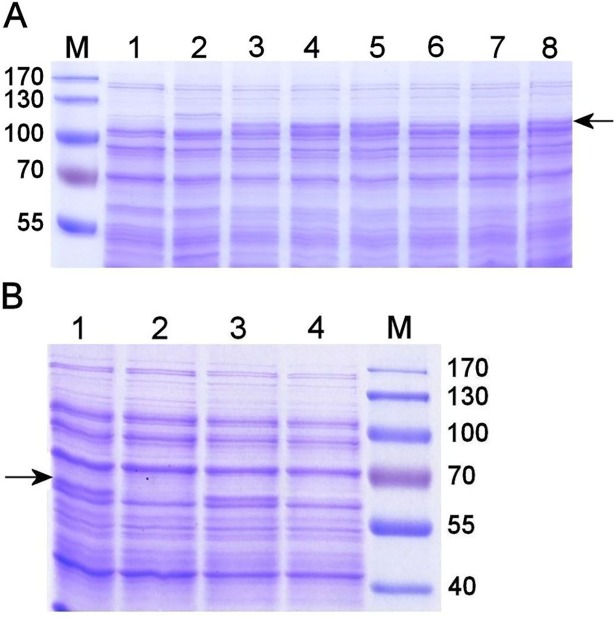
SDS-PAGE analysis of recombinant sialidases in E. coli lysates.(A) Filtered soluble fraction of cell lysates containing full-length sialidase from G. vaginalis isolates 47.3 (lane 3), 58.4 (lane 4), 60.1 (lane 5), 79.2 (lane 6), 86.1 (lane 7), and 114.2 (lane 8). As controls, filtered soluble fractions of E. coli cell lysate before induction (lane 1) and of non-transformed cells (lane 2) were loaded on the gel. (B) The catalytic domain of sialidase from G. vaginalis isolates 86.1 and 114.2 was expressed in E. coli, and the cleared cell lysates before (lanes 1 and 3) and after (lanes 2 and 4) filtration were analyzed. M, Page Ruler Prestained Protein Ladder (Thermo Fisher Scientific). Arrows indicate the migration positions of recombinant sialidases.